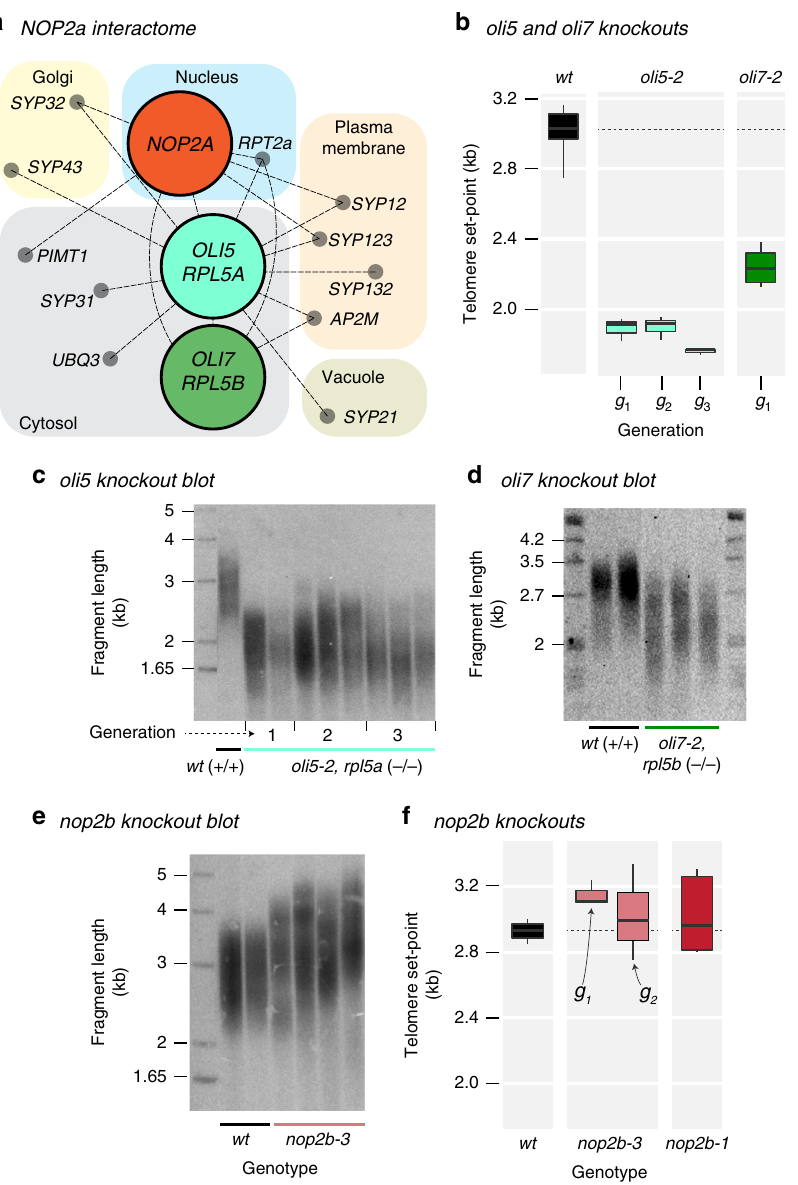
Fig. 4 Speci fi c components of ribosome assembly and rRNA biogenesis pathway control the establishment of telomere length set point in Arabidopsis. a Protein interactions ( ‘ interactome ’ ) of OLI2/NOP2A, OLI5/RPL5A, and OLI7/RPL5B, genes previously identi fi ed in a forward genetic screen for OLIGOCELLULA cell proliferation mutants 29 , are shown. The edges in the network connect predicted interacting proteins (nodes), which are grouped by their predicted cellular locations. b Boxplots indicate the signi fi cantly shorter telomeres in rpl5a/oli5-2 and rpl5b/oli7-2 mutants relative to the wild type. c , d Examples of TRF southern blots of rpl5a/oli5-2 and rpl5b/oli7-2 mutants. Arabidopsis RPL5A/OLI5 ( c ) and RPL5B/OLI7 ( d ) T-DNA knockout plants harbor stable telomere phenotypes with a new shorter length set point. e Example of TRF southern blot for nop2b-3 mutants. Unlike NOP2A mutants, Arabidopsis NOP2B T-DNA knockout plants harbor telomere length in the wild type range. f Boxplots (midline = median, box = interquartile range (IQR), whiskers = 1.5*IQR) indicate telomere lengths in nop2b-1 and nop2b-3 mutants relative to the wild type. The y -axis scale has been extended to